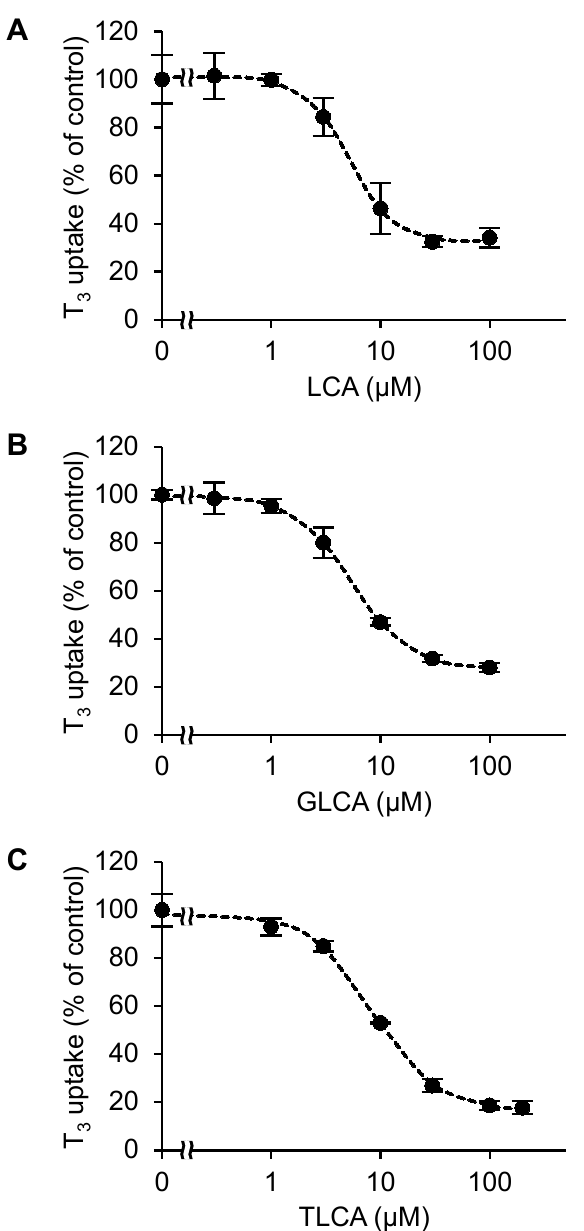
Figure 3. Concentration dependence of the inhibitory effect of the bile acids on the OATP4C1-mediated T 3 transport. ( A ) LCA, ( B ) GLCA, and ( C ) TLCA. The T 3 concentration was 1 µ M and the cells were incubated for 10 min at 37 ◦ C. The bile acid concentrations were 0, 0.3, 1, 3, 10, 30, and 100 µ M for LCA and GLCA, and 0, 1, 3, 10, 30, 100, and 200 µ M for TLCA. The OATP4C1-mediated transport was calculated by subtracting the nonspecific uptake of T 3 by the mock cells from the total cellular uptake by the OATP4C1-expressing cells. Each point and bar represent the mean ± standard error of the mean ( n = 3). The data are shown as the percentages of transport relative to the control. The dotted lines represent the fitted line obtained by nonlinear least squares regression